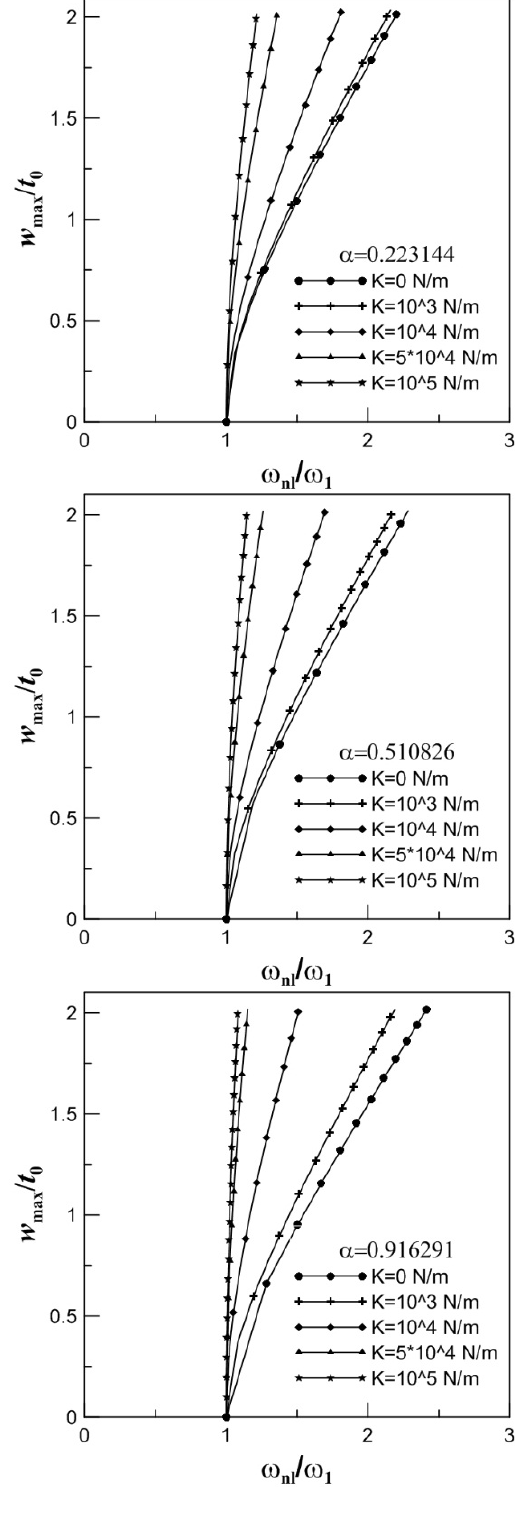
Figure 9: Backbone curve of AFG exponential taper beam ( E ( ξ ) = E 0 , ρ ( ξ ) = ρ 0 ) on elastic